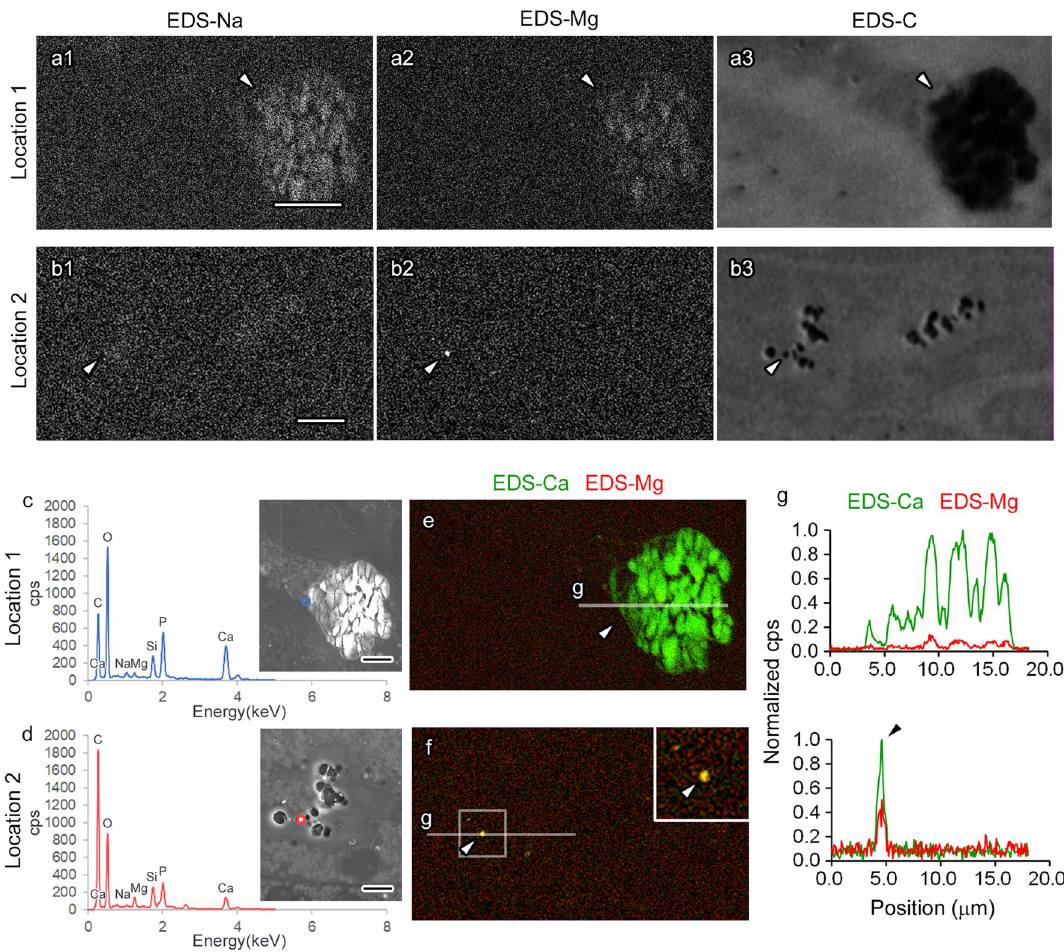
Figure 4. Differential composition of elements among calcium phosphate particles (CaPs) formed in the kidney under a short-term high phosphate diet (HPD). The energy-dispersive X-ray spectroscopy (EDS) images of the two CaPs ( a , b ) indicated in Fig. 3d,e, respectively, demonstrate the intensities of sodium (EDS-Na, a1 , b1 ), magnesium (EDS-Mg, a2 , b2 ), and carbon (EDS-C, a3 , b3 ). In the EDS spectrum of the particles ( c , d , blue or red line), the peaks of some elements, including magnesium, appear different ( c , d ). In the images where EDS-Ca and EDS-Mg signals are colored green and red, respectively, and merged ( e , f ), the line plots ( g , correspond to the white lines in e and f ) on the particles ( e , f , arrowheads) indicate that the magnesium intensity in the small particle is higher than the adjacent background pixels ( f , g , arrowheads). Scale bars: 10-μm ( a , b ) or 5-μm ( c , d